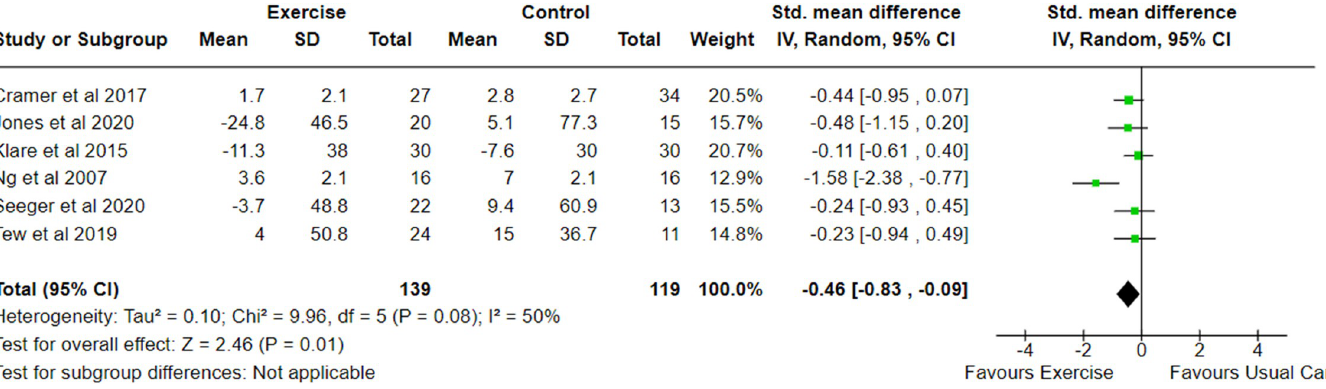
Fig 2. Meta-analysis of change in disease activity scores following an exercise intervention in adults with IBD. SD, Standard Deviation; Std, Standard; IV, Weight Mean Difference; CI, Confidence Interval.